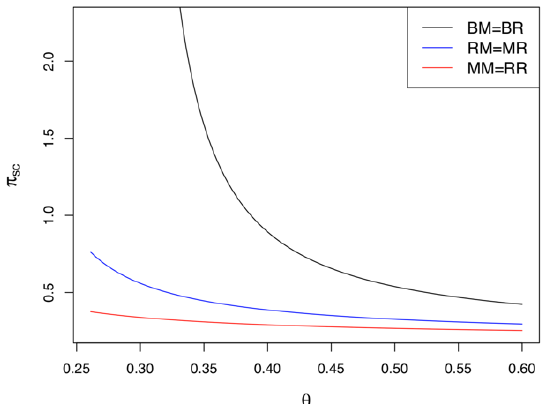
Figure 9. Comparisons of the supply chain profits among different models.